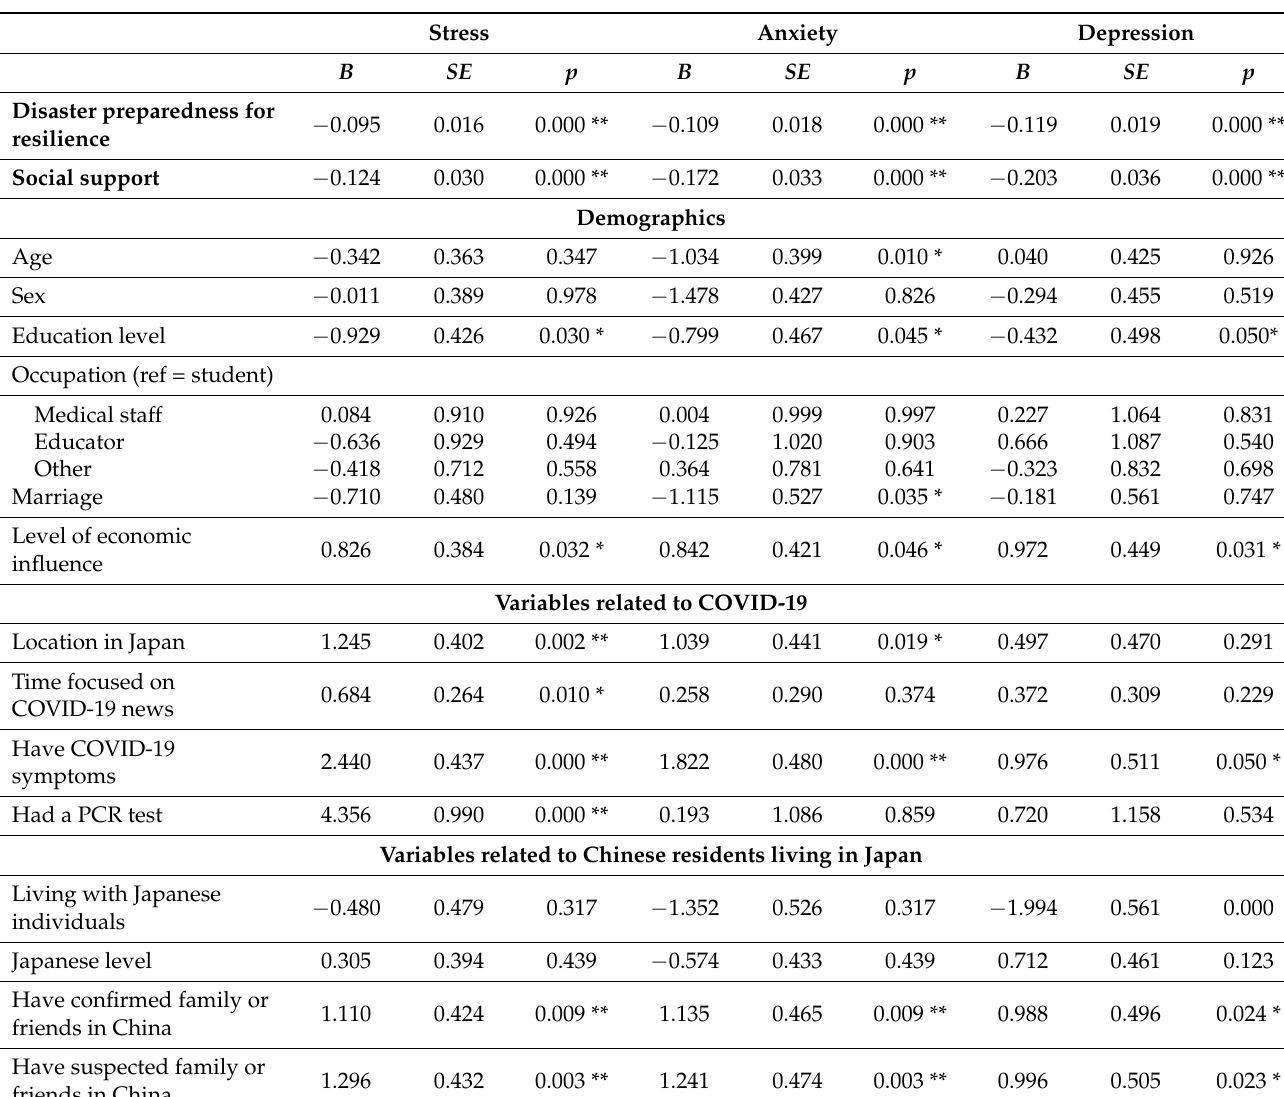
Table 3. Association of disaster preparedness and social support with depression, anxiety, and stress. Stress Anxiety